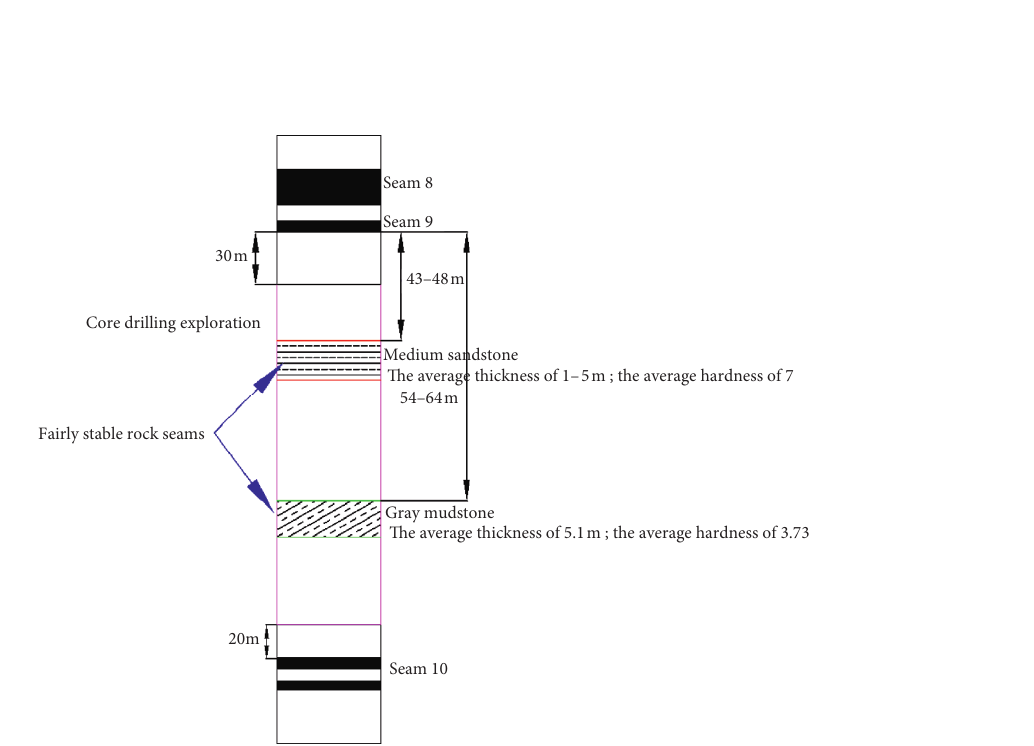
Figure 16: Determination of the horizon of rock